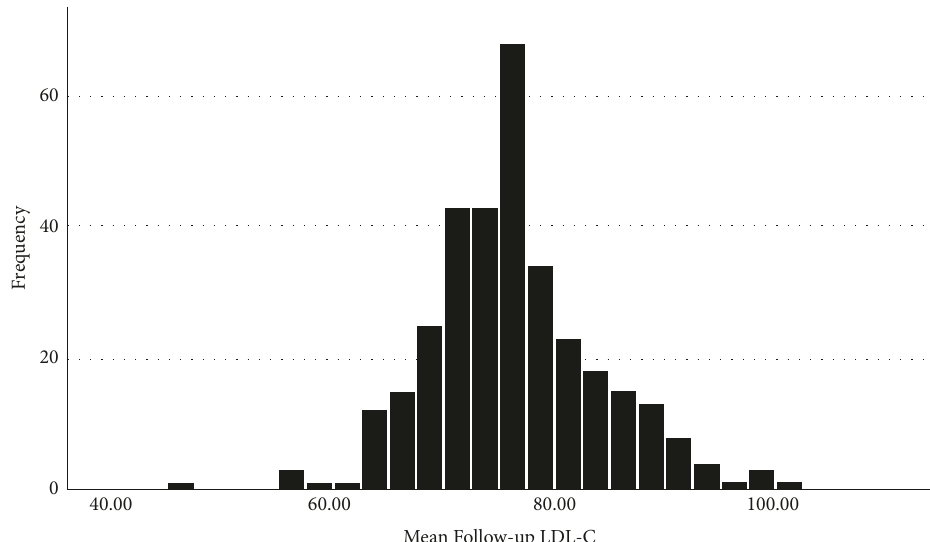
Figure 2: Distribution of mean final follow-up low-density lipoprotein cholesterol mg/dL among 332 health system physicians with at least 10 study patients ( N � 12,888 study